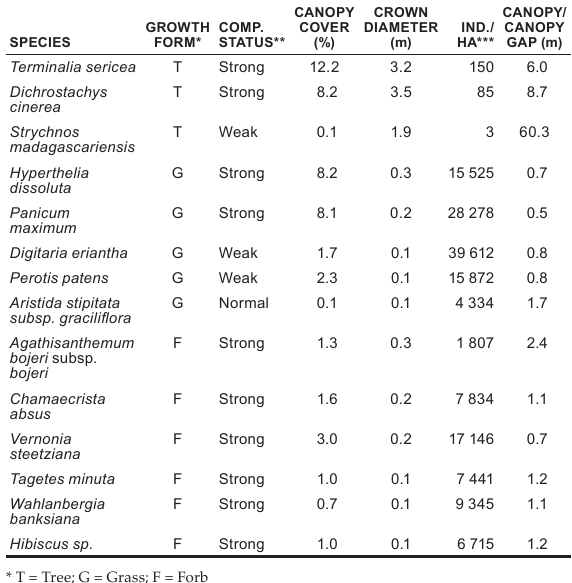
table 6 Species and growth form relations in Variant 1b